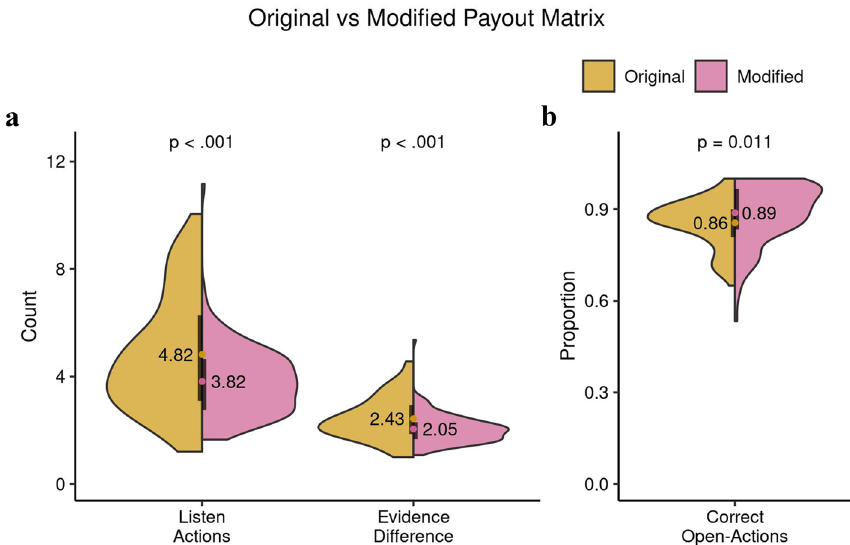
Figure 5. Behavioral indices: Comparison of the single-agent versions of the TT. This Figure compares the participants’ performance difference in the original version with the modified version of the payout matrix. It shows the mean values with their distributions in the form of the split violin plot. The black bars cover the interquartile range. In ( a ), we see the number of listen actions and the evidence-differences are significantly lower in the modified version. In ( b ), the number of correct open actions are higher in the modified